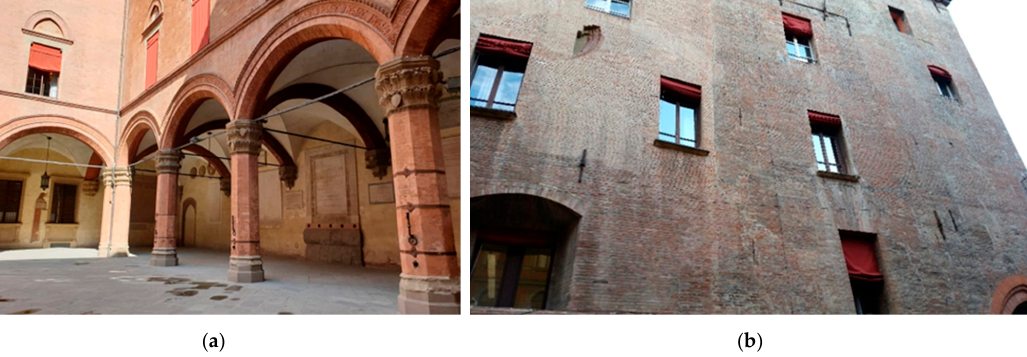
( b ) Figure 11. Single ( a ) and double ( b ) steel tie-rods used for arch and vault reinforcement, Bologna, Italy. Figure 12a shows a coupled cross vault system in Bologna, Italy, in which the central columns mainly support gravity forces since tie rods are applied for transmitted thrust